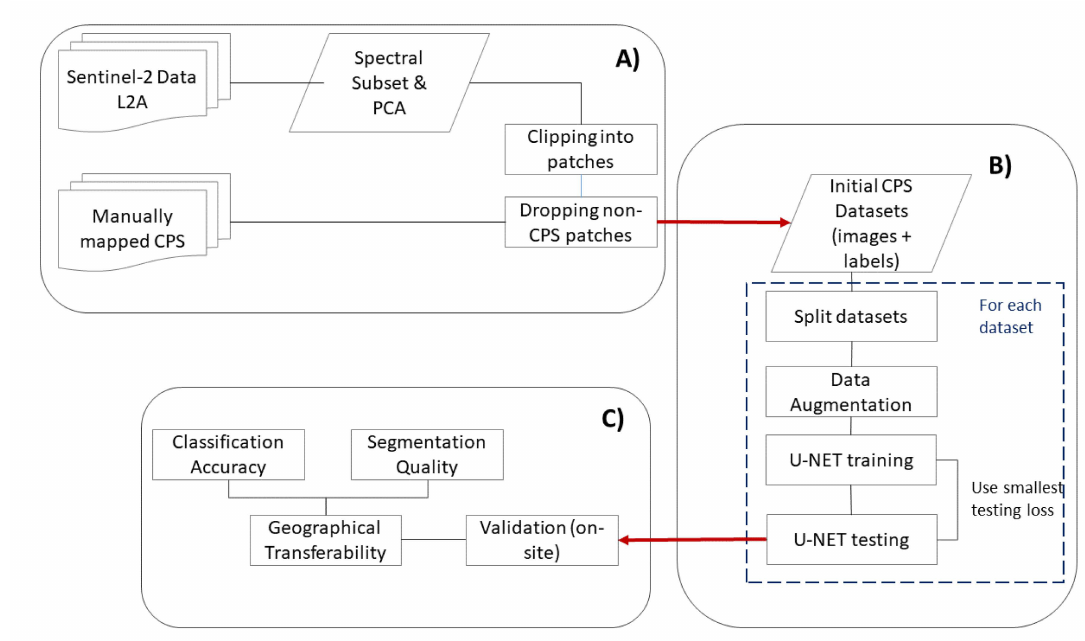
Figure 2. Workflow used for setting up, training and validation of the two U-NET models (SPECS and principal component analysis (PCA)). In ( A ), the Sentinel-2 data preprocessing is shown, whereas ( B ) accounts for the generation of training data and the model training process. The best performing model in terms of smallest testing loss is used to assess the geographic transferability in terms of classification accuracy and segmentation quality ( C ) for each of the two U-NET